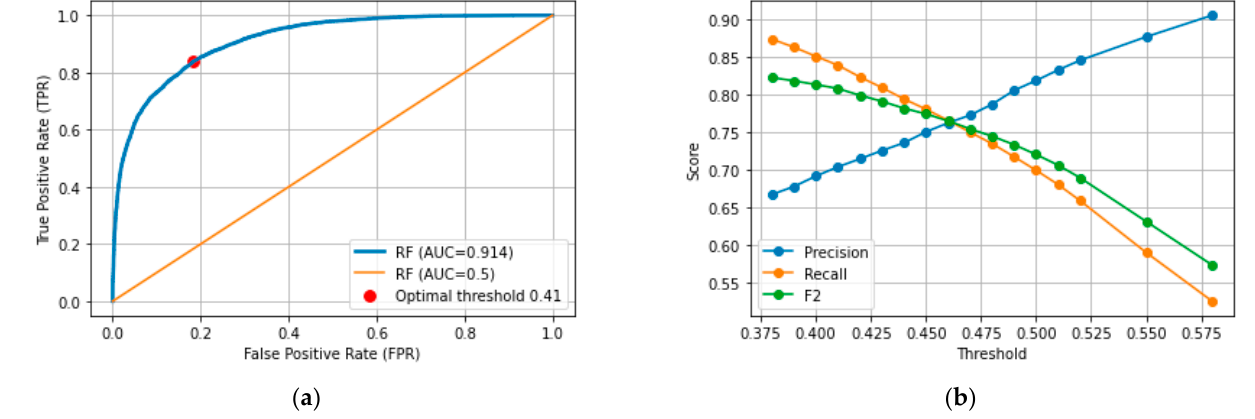
Figure 9. ( a ) ROC curve and AUC for the RF-US model. ( b ) Accuracy measures for the validation test as a function of the threshold.